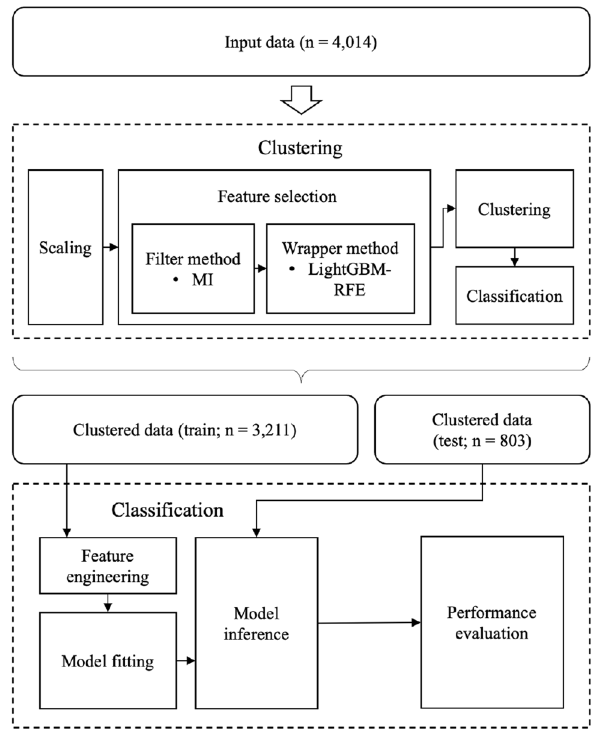
Figure 1. The workflow of the predictive